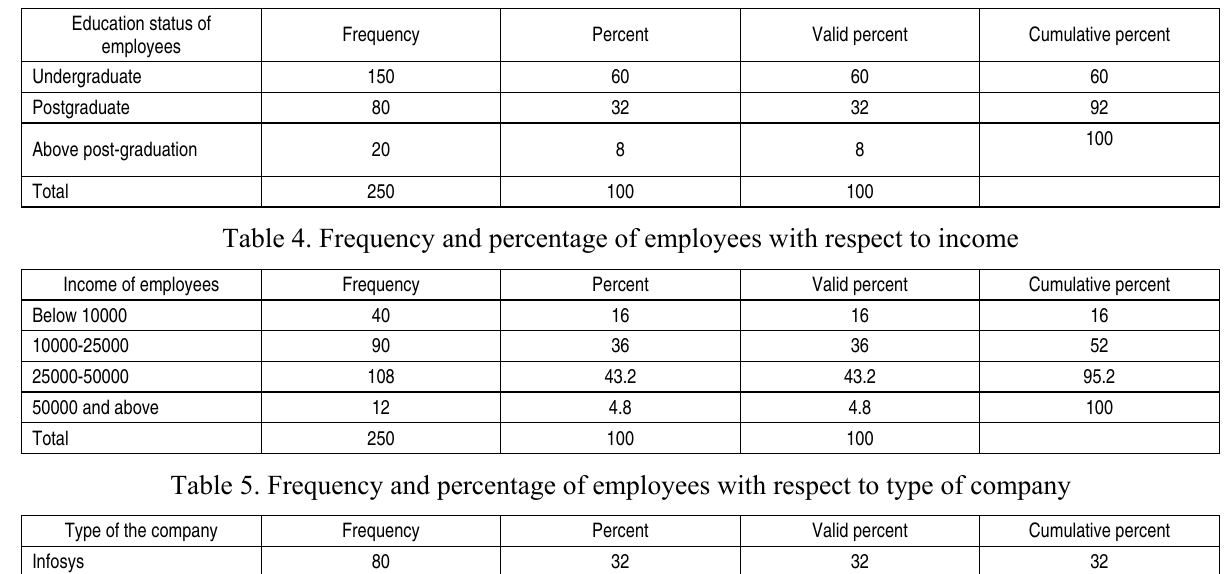
Table 3. Frequency and percentage of employees with respect to education